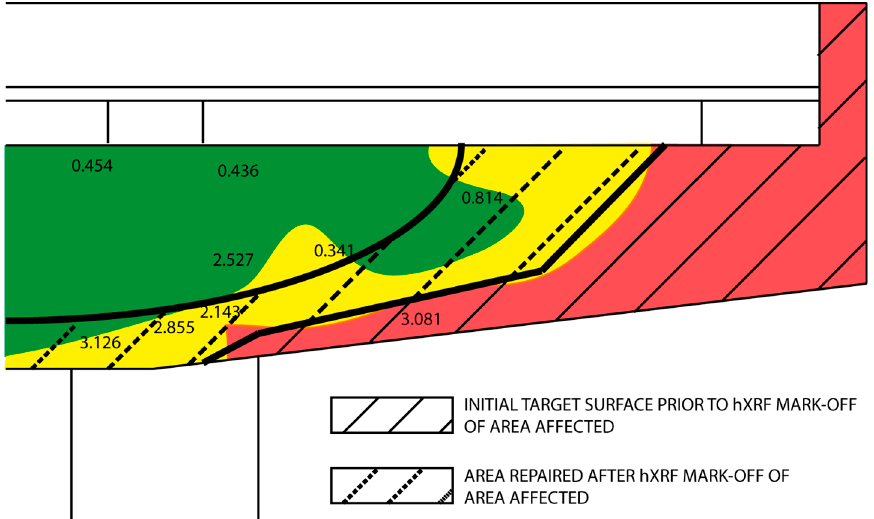
Figure 6. Electrochemical mapping (shading) and chloride concentrations in wt % cement (numbers). Initial (solid black lines) and final areas (dotted black lines) targeted for repair are also shown in straight and dotted lines, respectively.